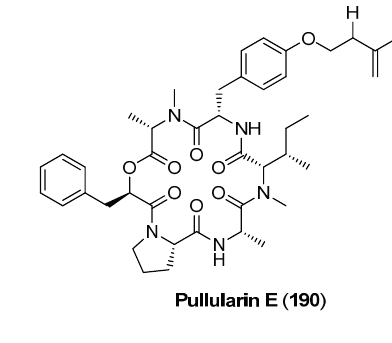
Figure 19. Structures of pullularins A-E ( 186 – 190 ).